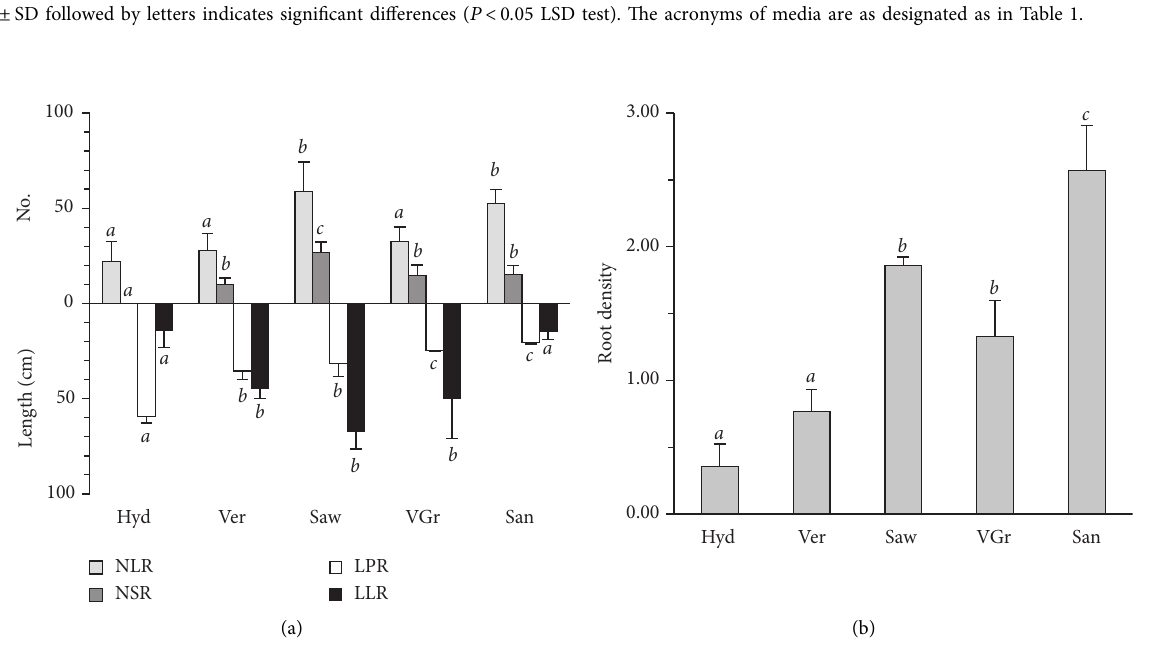
Figure 2: Root architecture of Cedrus atlantica Manetti in response to the variation of the substratum hydromechanical constraint. (a) Number of lateral roots (NLR) and short roots (NSR); length of the main root (LPR) and lateral roots (LLR). (b) Lateral root density. Letters indicate significant differences ( P < 0 . 05 LSD test). The acronyms of media are as designated as in Table 1.